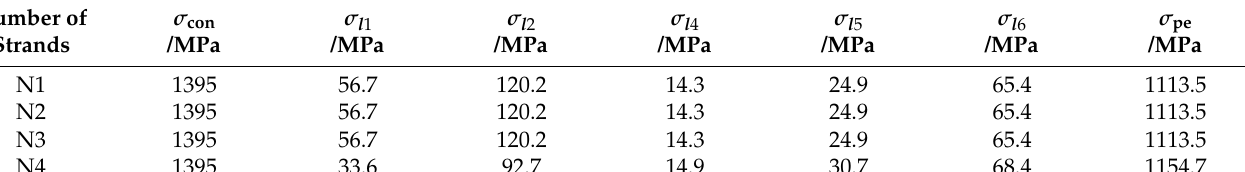
Table 6. Calculation of prestress loss. Table 4. Details in the stress-strain curves of reinforcements and prestressed strands.